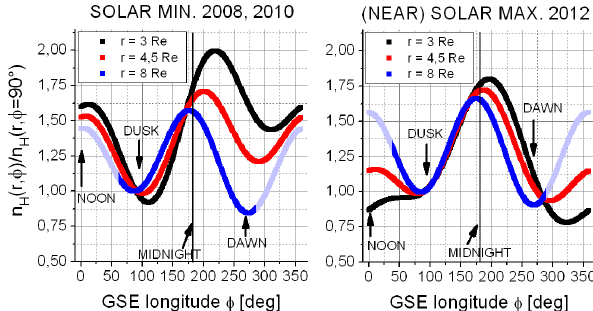
Figure 12. Longitudinal H density N(r , φ ) normalized to the dusk H density N(r , φ = 90 ◦ ) for three distances: 3 R e (black), 4 . 5 R e (red) and 8 R e (blue). Light-blue indicates missing or bad observa- tional coverage in this